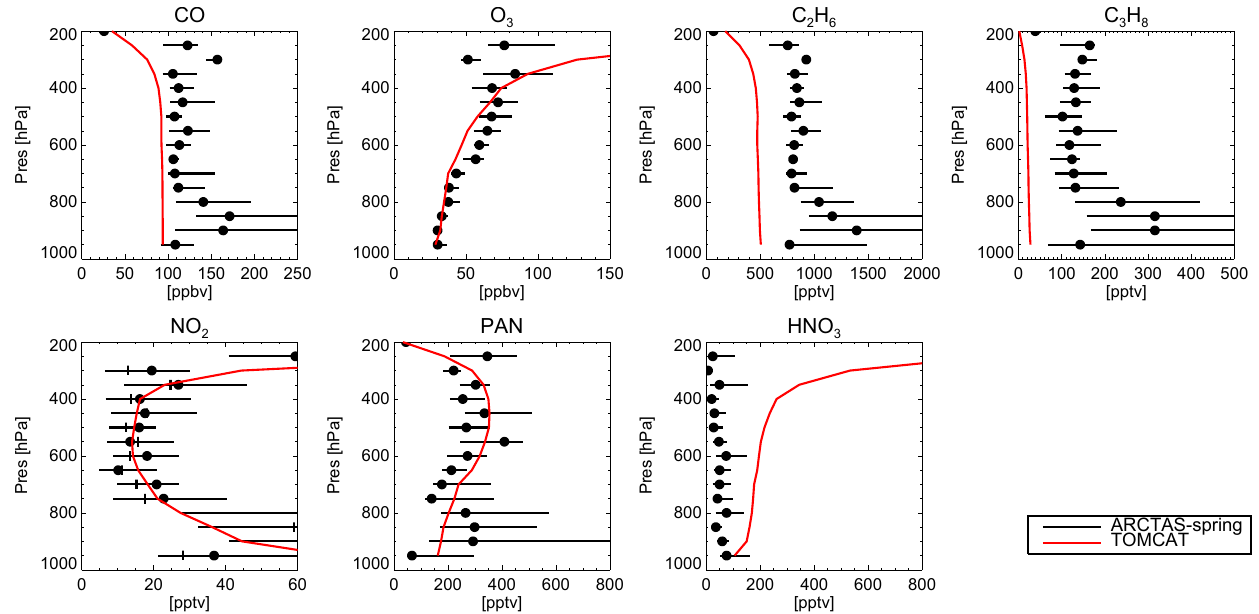
Figure 12. Comparison of simulated and observed concentrations of CO, O 3 , C 2 H 6 , C 3 H 8 , NO 2 , PAN and HNO 3 for the ARCTAS July 2008 flights (seven flights).